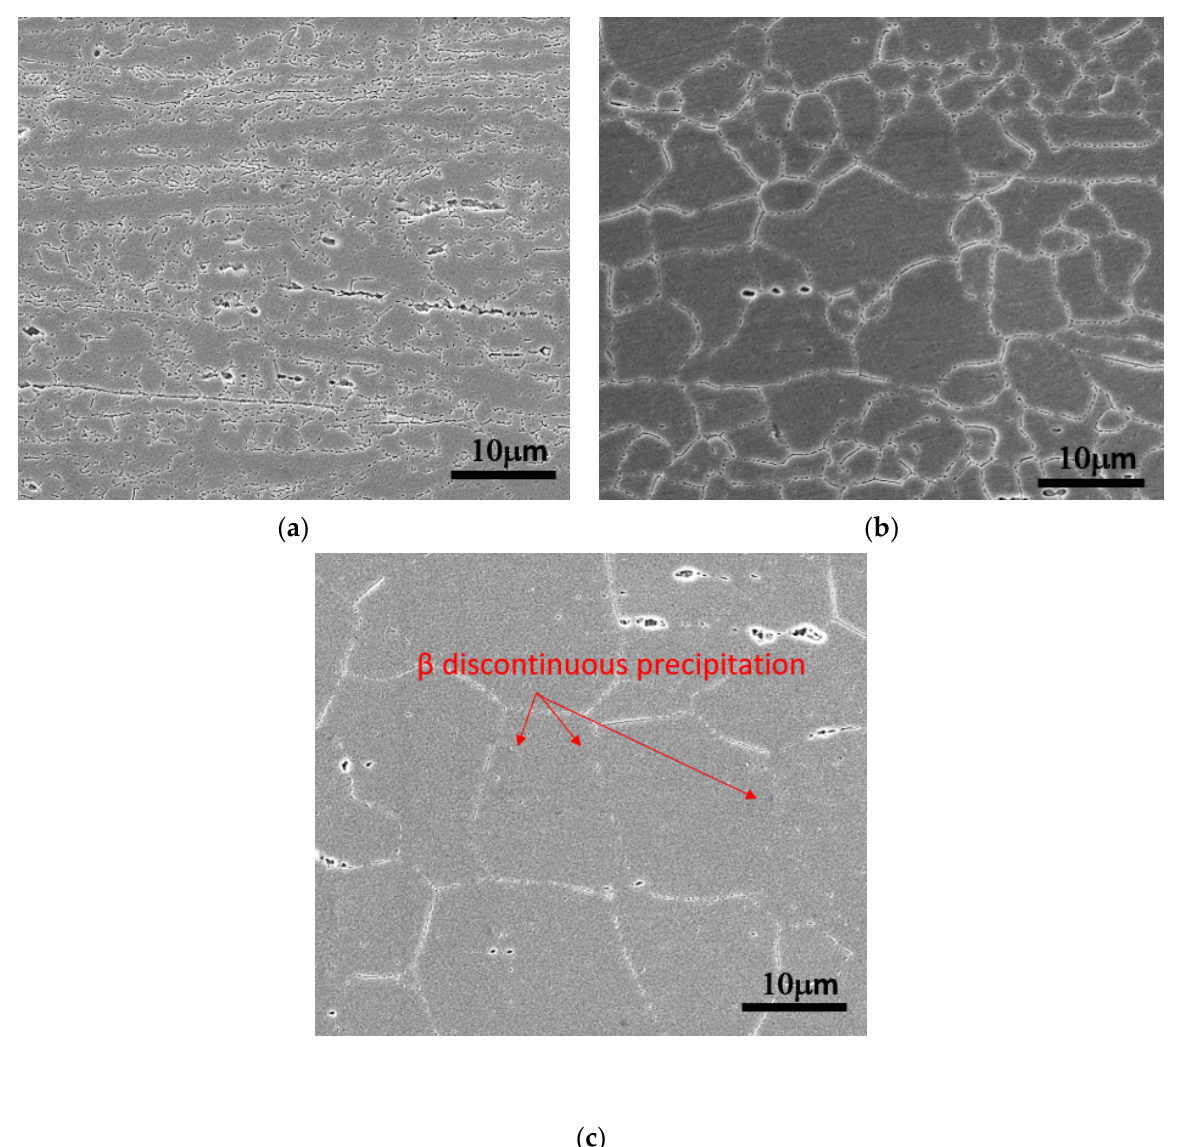
Figure 6. Precipitation micrographs of β phase under different sensitization treatments: ( a ) alloy A(0.1Mn) annealed at 250 °C; ( b ) alloy A(0.1Mn) annealed at 350 °C; ( c ) alloy A(0.1Mn) annealed at 450 °C.